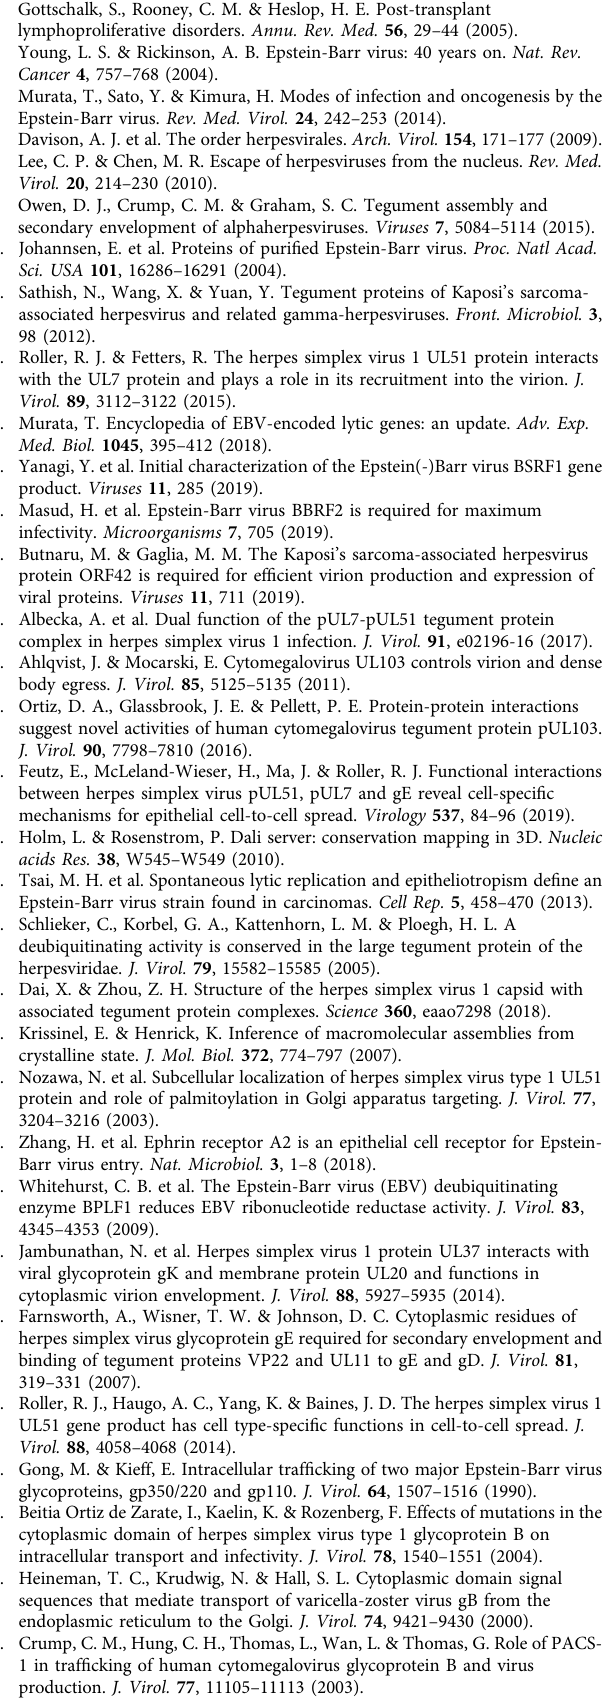
Peptide transfection assay . TAT-peptides were dissolved in RPMI1640. Different concentrations of peptides were added to preseeded CNE2-EBV cells in a 12-well plate and incubated for 2h at 37°C. Cells were subsequently washed three times with PBS before being transferred to RPMI1640 supplemented with 10% FBS, penicillin/streptomycin, sodium butyrate, and PMA. After 48h, the number of EBV genome copies in these cells were counted. EBV genome copy determination . CNE2-EBV cells pretransfected with TAT- peptide were treated with 2.5mM sodium butyrate and 20ngml − 1 phorbol 12- myristate 13-acetate (PMA) for 12 h to induce the production of EBV virions. After 48h, the cells were collected and washed three times with PBS to measure viral replication, and the remaining medium was fi ltered through a 0.45- μ m fi lter and centrifuged at 1000 × g for 10min at 4°C to remove the cell debries. The amount of encapsidated viral genome DNA was determined by a qPCR analysis of viral supernatants 61 . Brie fl y, the encapsidated viral genome DNA was extracted from induced cells by using a QIAamp DNA tissue kit (QIAGEN). The supernatant was digested with DNase I (105 U ml − 1 ) at 37 °C for 1h to degrade the naked EBV genome DNA before mixing it with lysis buffer and 0.1 mgml − 1 Proteinase K. Proteinase K was added to remove the viral envelope and capsid. The mixture was heated at 56°C for 10 min, and then 75°C for 20 min to deactivate the enzymes. The sample was diluted 1:10 by RNase-free water and subsequently applied